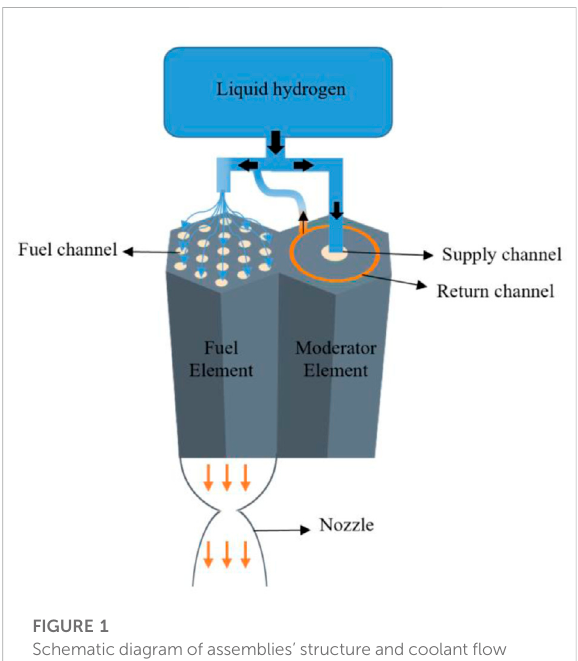
FIGURE 1 Schematic diagram of assemblies ’ structure and coolant fl ow within